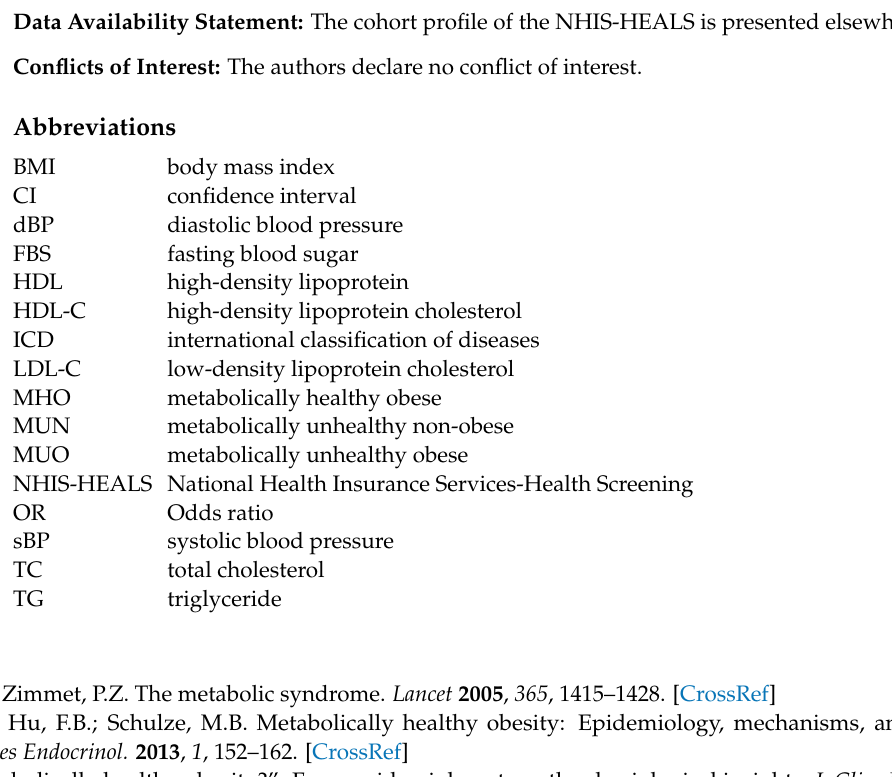
Table S3: List of ICD-10 codes selected in the